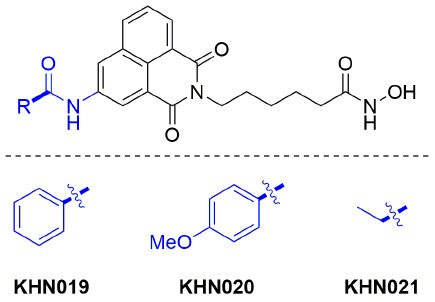
Figure 4. Target 3-amido scriptaid analogues.